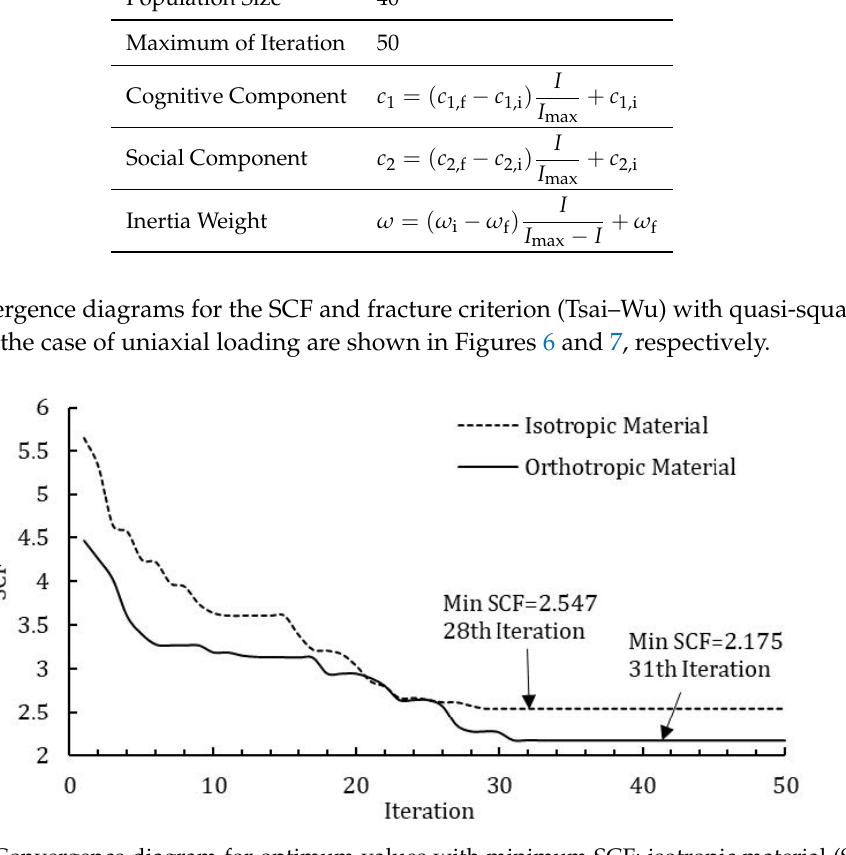
Figure 6. Convergence diagram for optimum values with minimum SCF: isotropic material (Steel: w = 0.052, θ 1 = 90 ◦ , and θ 3 = 135 ◦ ) and orthotropic material (Graphite/Epoxy (T300/5208): w = 0.035, θ 1 = 0 ◦ , θ 2 = 90 ◦ , and θ 3 = 135.5 ◦